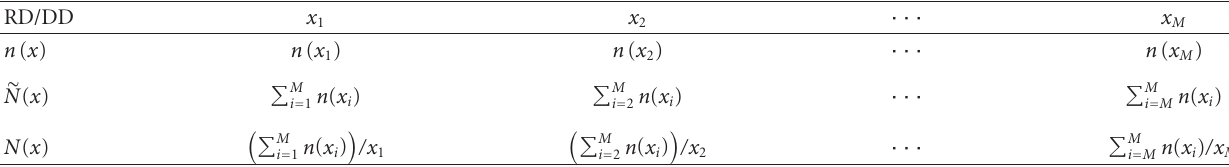
Table 2: Distribution model of rain duration and drought